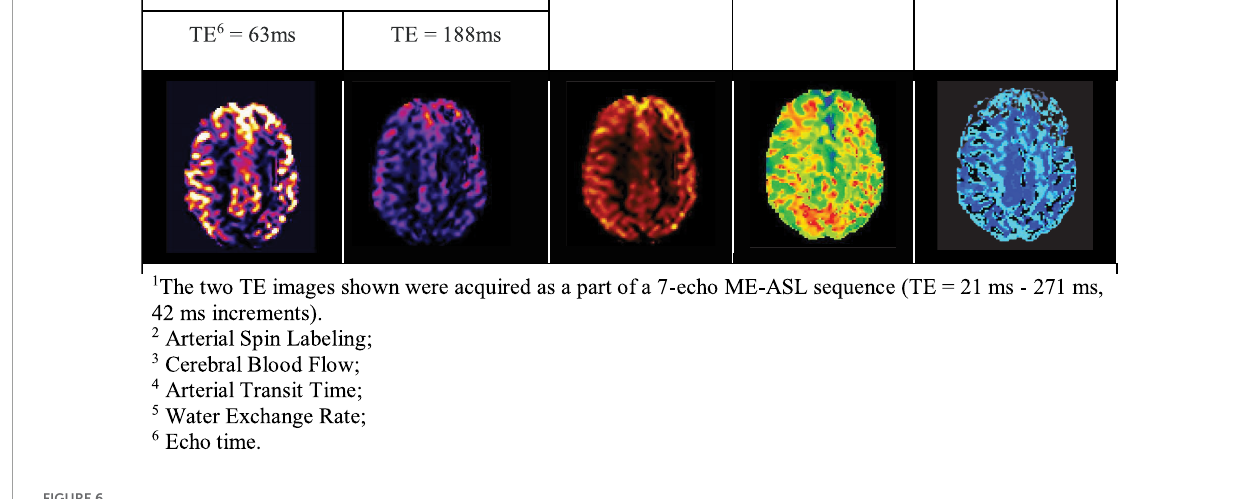
disease management, prevention, as well as drug